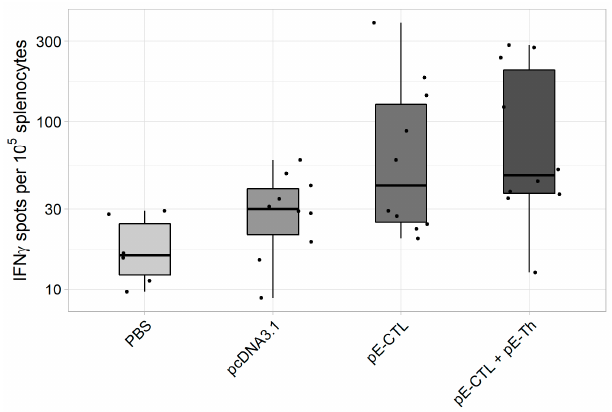
Figure 4. The results of IFN γ -producing T-cell count in IFN γ -ELISpot assay in BALB/c mice immunized with DNA-vaccine constructs encoding target immunogens (n = 6 for phosphate buffer solution (PBS) control group and n = 10 for the other groups). The figure represents spot count (i.e. IFN γ -producing T-cells) in different experimental and control animal groups. Table 3. Results of statistical data analysis in ELISpot.